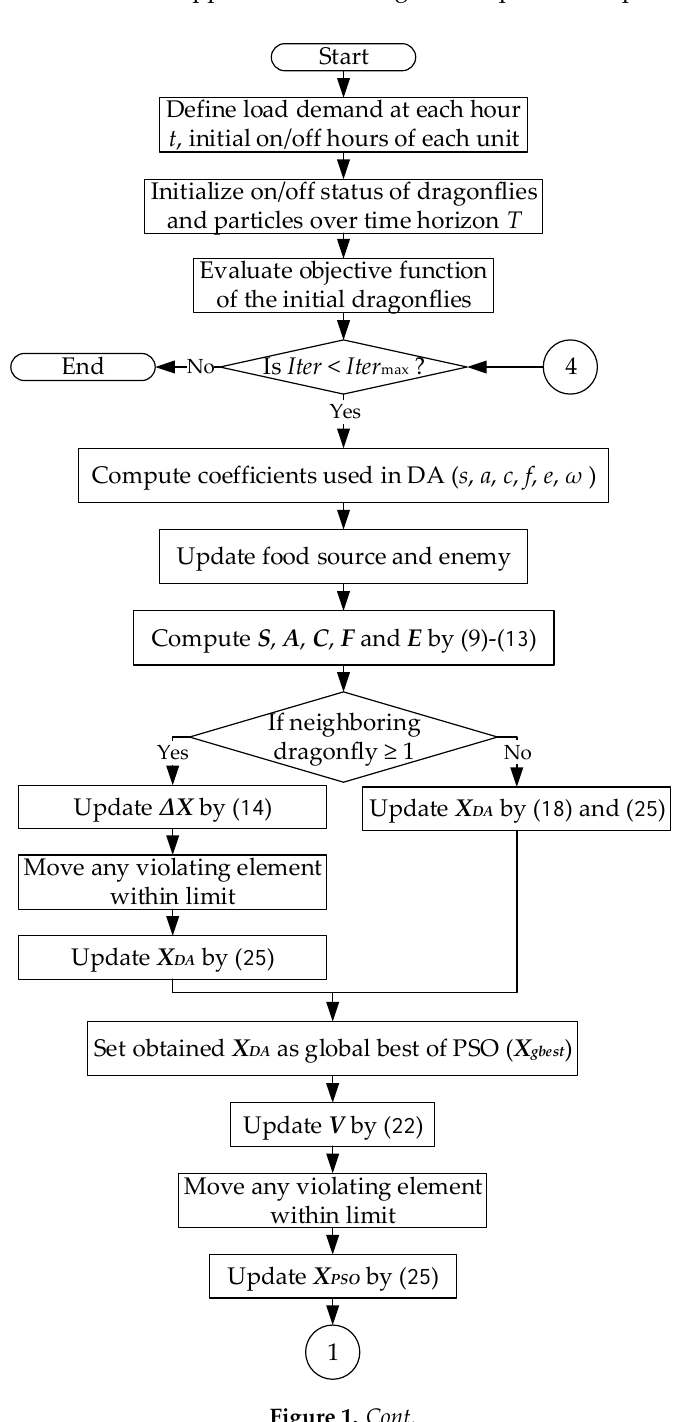
Figure 1 . Flowchart of Improved Dragonfly Algorithm-Particle Swarm Optimization (iDA-PSO) approach for Unit Commitment (UC)